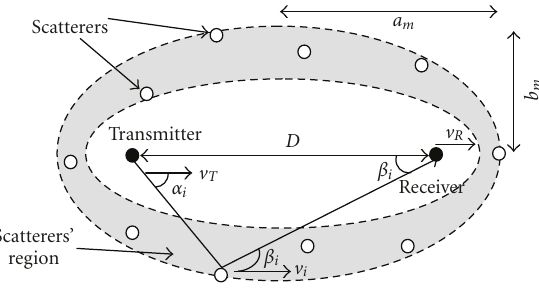
Figure 1: Proposed elliptical